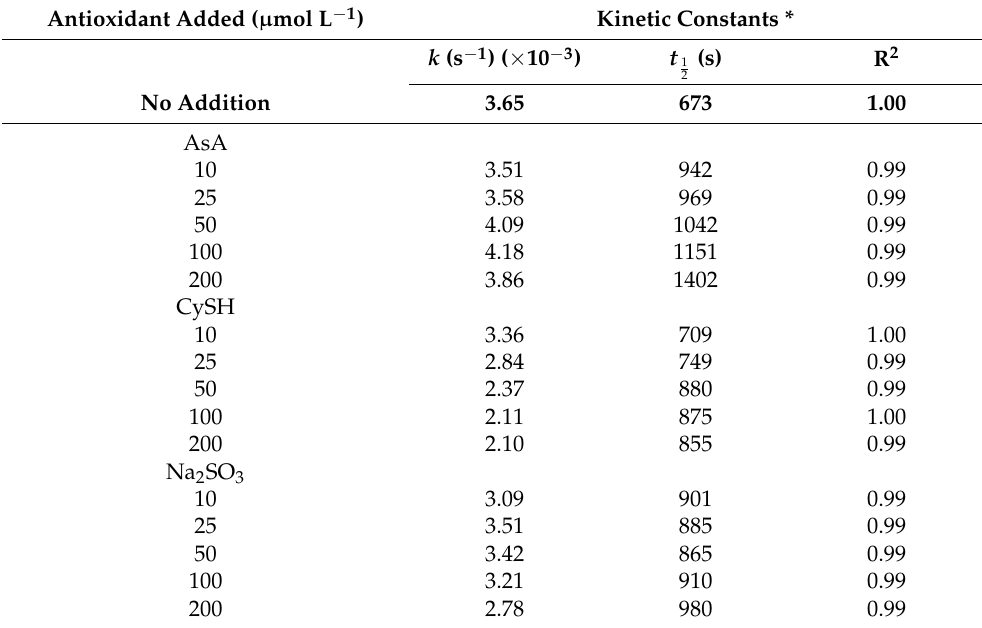
Table 3. The effect of antioxidants on Qt degradation kinetics using the sigmoidal model.